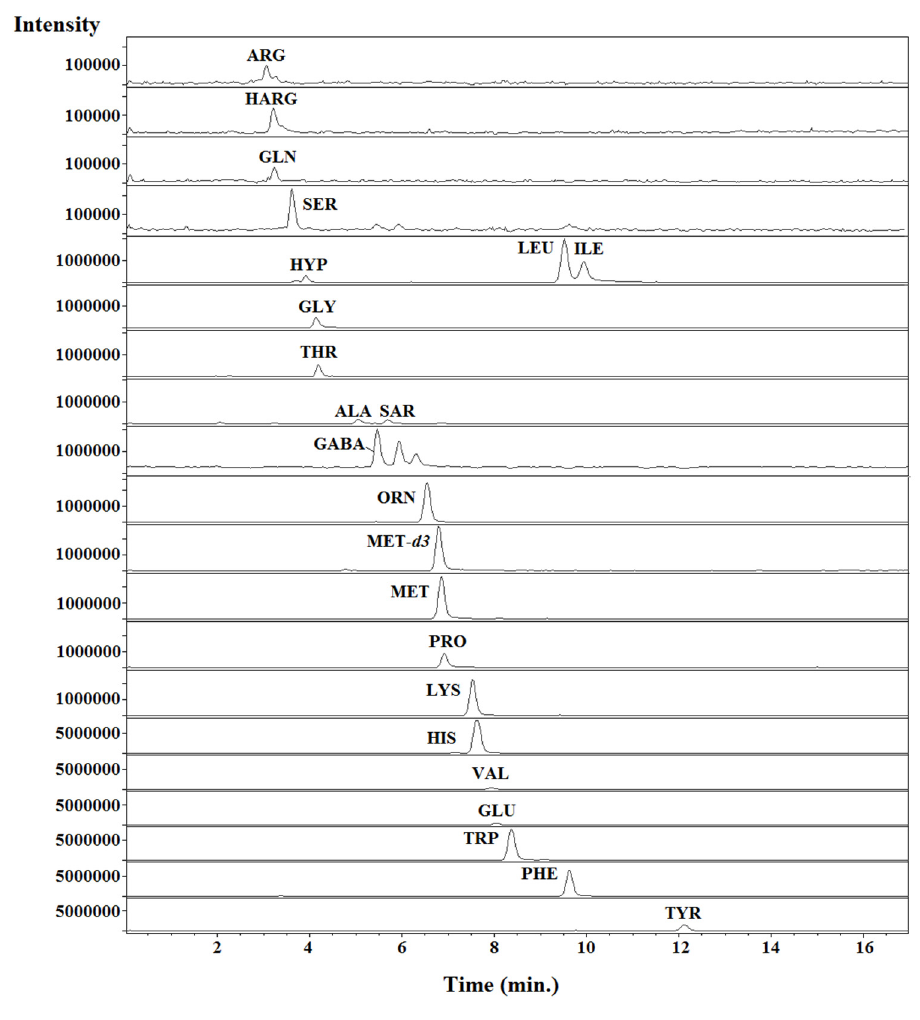
Figure 3. Representative chromatograms (SIM mode using the quantification ions; see Table 2) obtained from a standard in solvent mixture of free amino acids. The HPLC-MS conditions are summarized in Section 2.4.2 and Table 2.